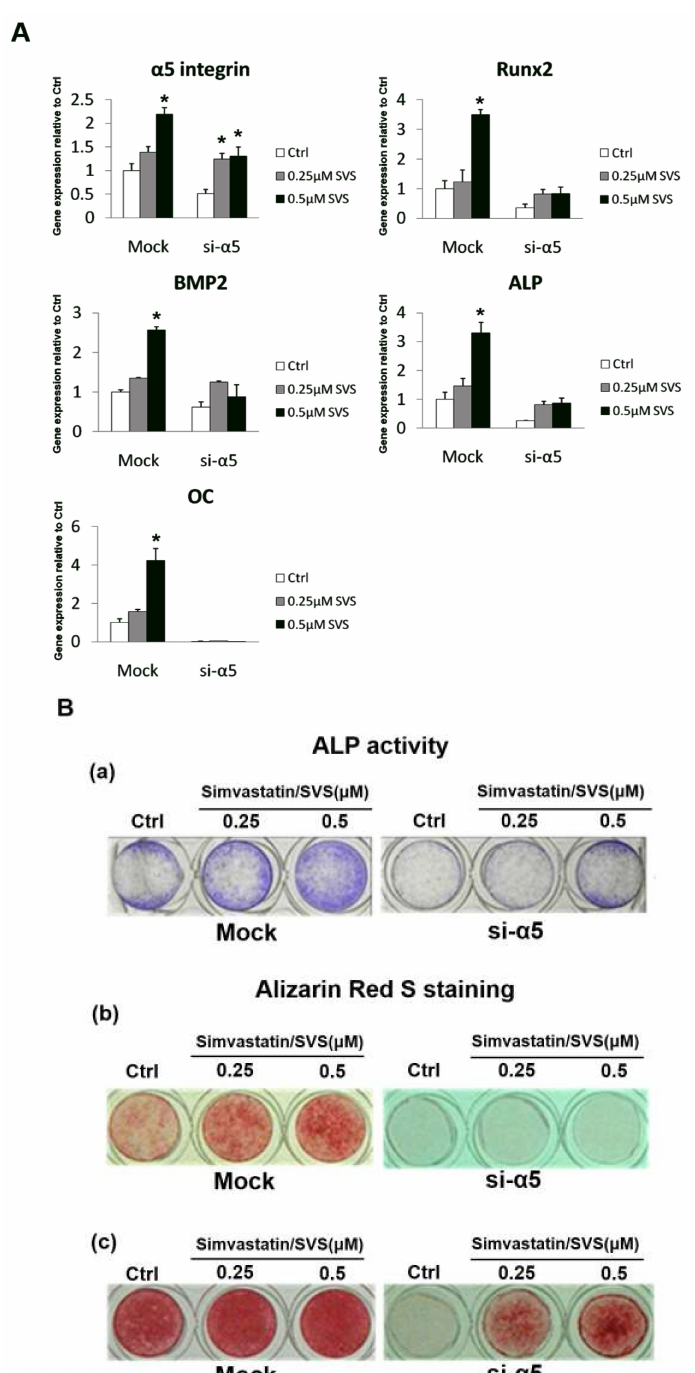
Figure 6. The effect of α 5 integrin silencing on SVS-induced mRNA expression levels of osteogenic marker genes, ALP activity and calcium deposition in D1 cells. D1 cells (passage 9) transfected with nonspecific control oligonucleotides (mock group) or α 5 integrin-specific siRNA (si- α 5 group) were treated with SVS at concentrations of 0 (Ctrl), 0.25 and 0.5 µ M for 3 days, and the medium was changed to osteoinduction for another 2 to 6 days. ( A ) The mRNA expression levels of the osteogenic marker genes ( α 5 integrin, Runx2, BMP-2, ALP, and OC) in the mock and si- α 5 group groups at day 3. The gene expression levels are expressed relative to that in the mock group at day 1, which is defined as 1. The values are presented as the mean ± SD ( n = 3), * p < 0.05 in comparison to the mock group. ( B ) ALP activity staining in the mock and si- α 5 groups on day 2 after the medium was changed to osteoinduction medium ( a ). Blue: staining for ALP activity. Alizarin red S staining of calcium deposition in the mock and si- α 5 groups on day 6 ( b ) and 8 ( c ) after the media was changed to osteoinduction medium. Red: Alizarin red S